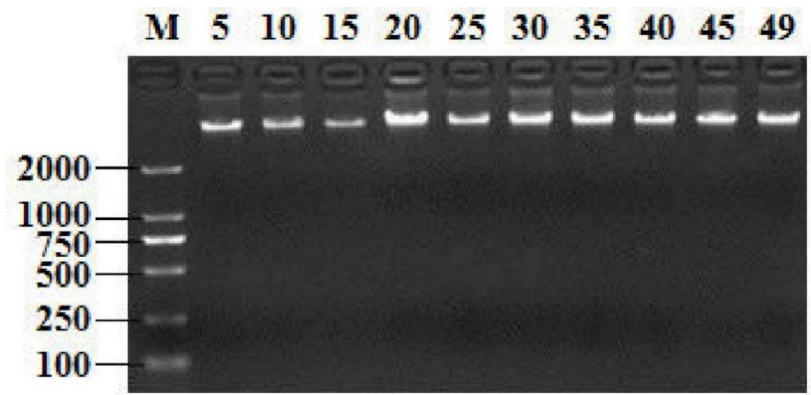
Figure 1. Partial electropherogram result of genomic DNA of isolated strains. M: DNA Maker DL2000; Lanes 5–49: DNA bands of 10 isolated strains.